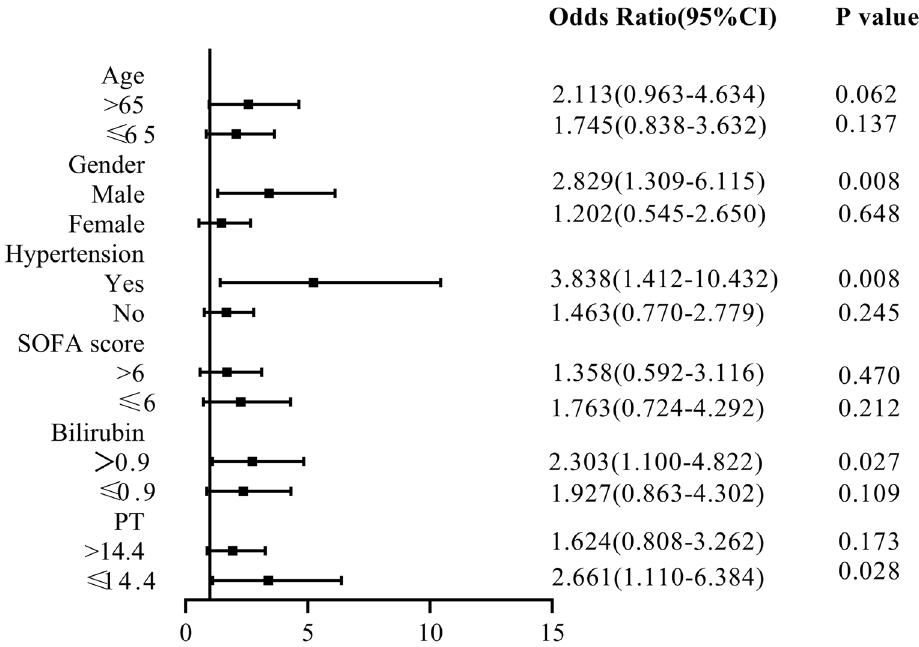
Figure 3. Subgroup analysis of the relationship between hyperuricemia and the incidence of AKI in patients with